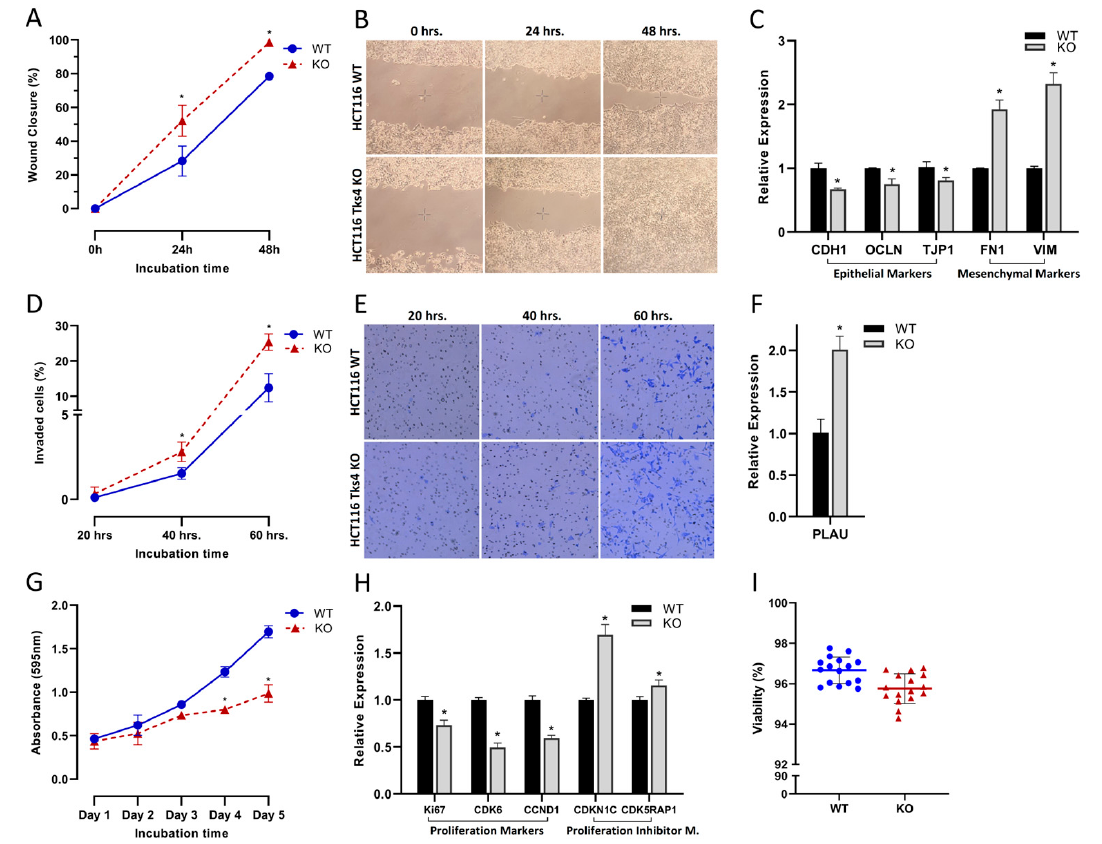
Figure 1. Effect of Tks4 on the motility, invasion, and proliferation. ( A ) Migration speed of the wild-type (blue) and Tks4 KO (red) HCT116 cells. ( B ) Wound healing assay showing cell migration of wild-type HCT116 cells (upper row) and Tks4 KO HCT116 cells (lower row). ( C ) Expression levels of epithelial and mesenchymal marker proteins. ( D ) Invasion capacities of wild-type (blue) and Tks4 KO (red) HCT116 cells. ( E ) Invasion assay of the wild-type (upper row) and the Tks4 KO (lower row) HCT cells. ( F ) Overexpression of the invasion marker PLAU (urokinase-type plasminogen activator), based on Q-PCR results. ( G ) Proliferation of the wild-type (blue) and Tks4 KO (red) HCT116 cells. ( H ) Changes in expression of proliferation markers and inhibitors upon the deletion of Tks4 based on the Q-PCR experiments. ( I ). Viability of the wild-type (blue) and the Tks4 KO (red) HCT116 cells. Results significant at p > 0.005 are marked with an asterisk.